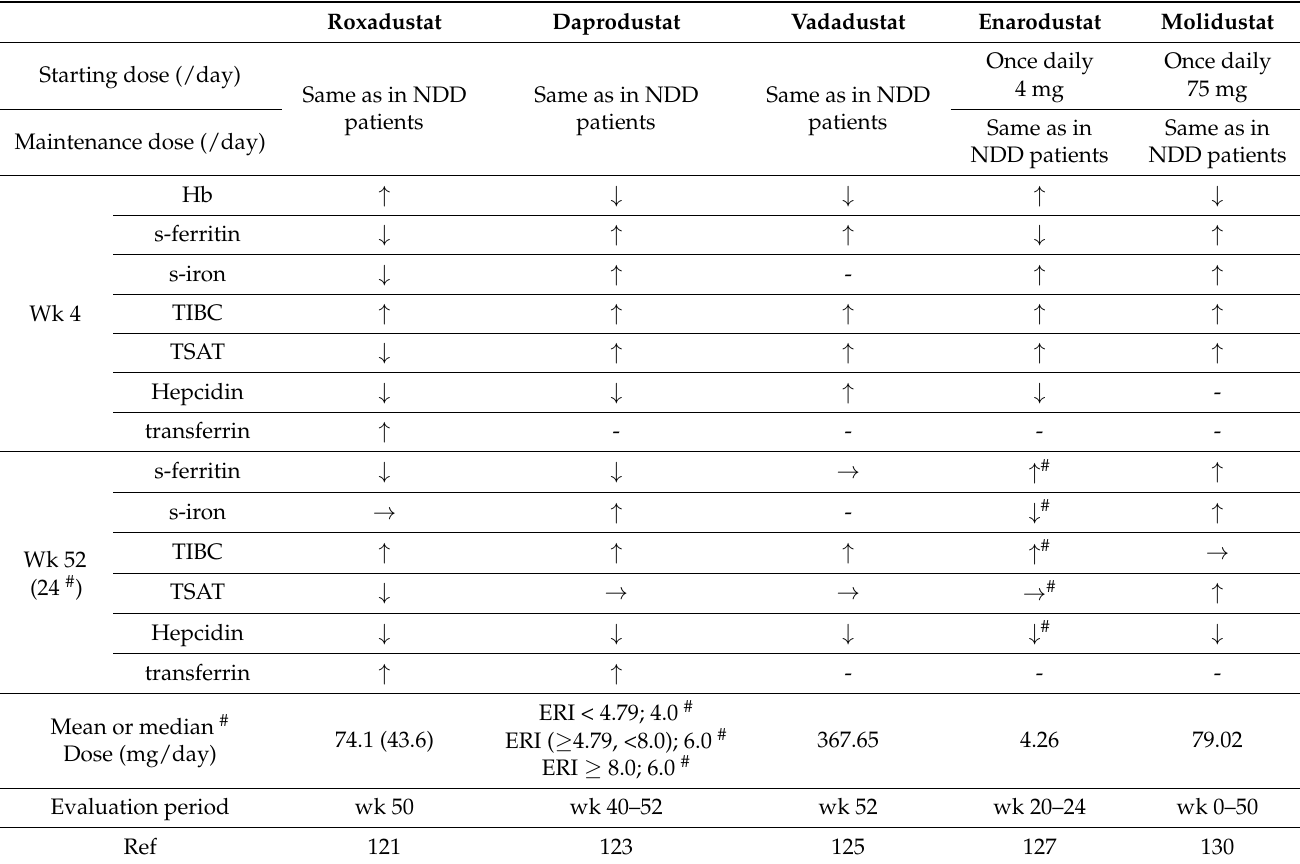
Table 2. Change from baseline in Hb and iron-related factors when switching from ESA to HIF-PHI in HD patients. Roxadustat Daprodustat Vadadustat Enarodustat Molidustat Once daily Once daily 4 mg 75 mg Same as in NDD Same as in NDD patients patients patients Same as in Same as NDD patients